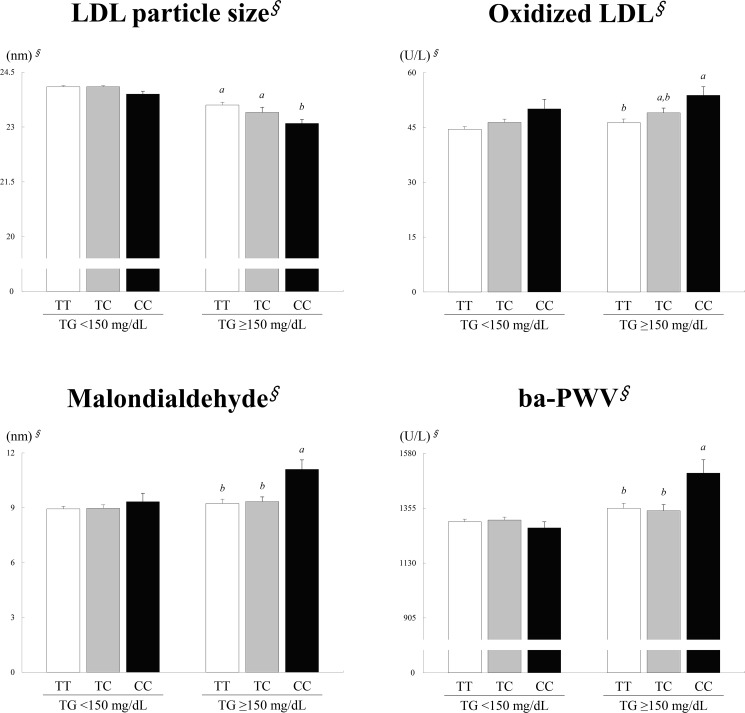
Association of the APOA5 -1131T>C polymorphism with LDL particle size, oxidized LDL and malondialdehyde levels, and ba-PWV in normotriglyceridemic controls (TG levels<150 mg/dL) and hypertriglyceridemic patients (TG levels≥150 mg/dL).Means ± SE. ∮Tested using logarithmic transformation. p-values for each group were derived by one-way ANOVA. All letters represent p<0.05, as derived using Bonferroni post hoc tests after adjusting for age, sex, BMI, smoking, and drinking; differences that are not significant are marked with the same letter, and significant differences are marked with different letters.